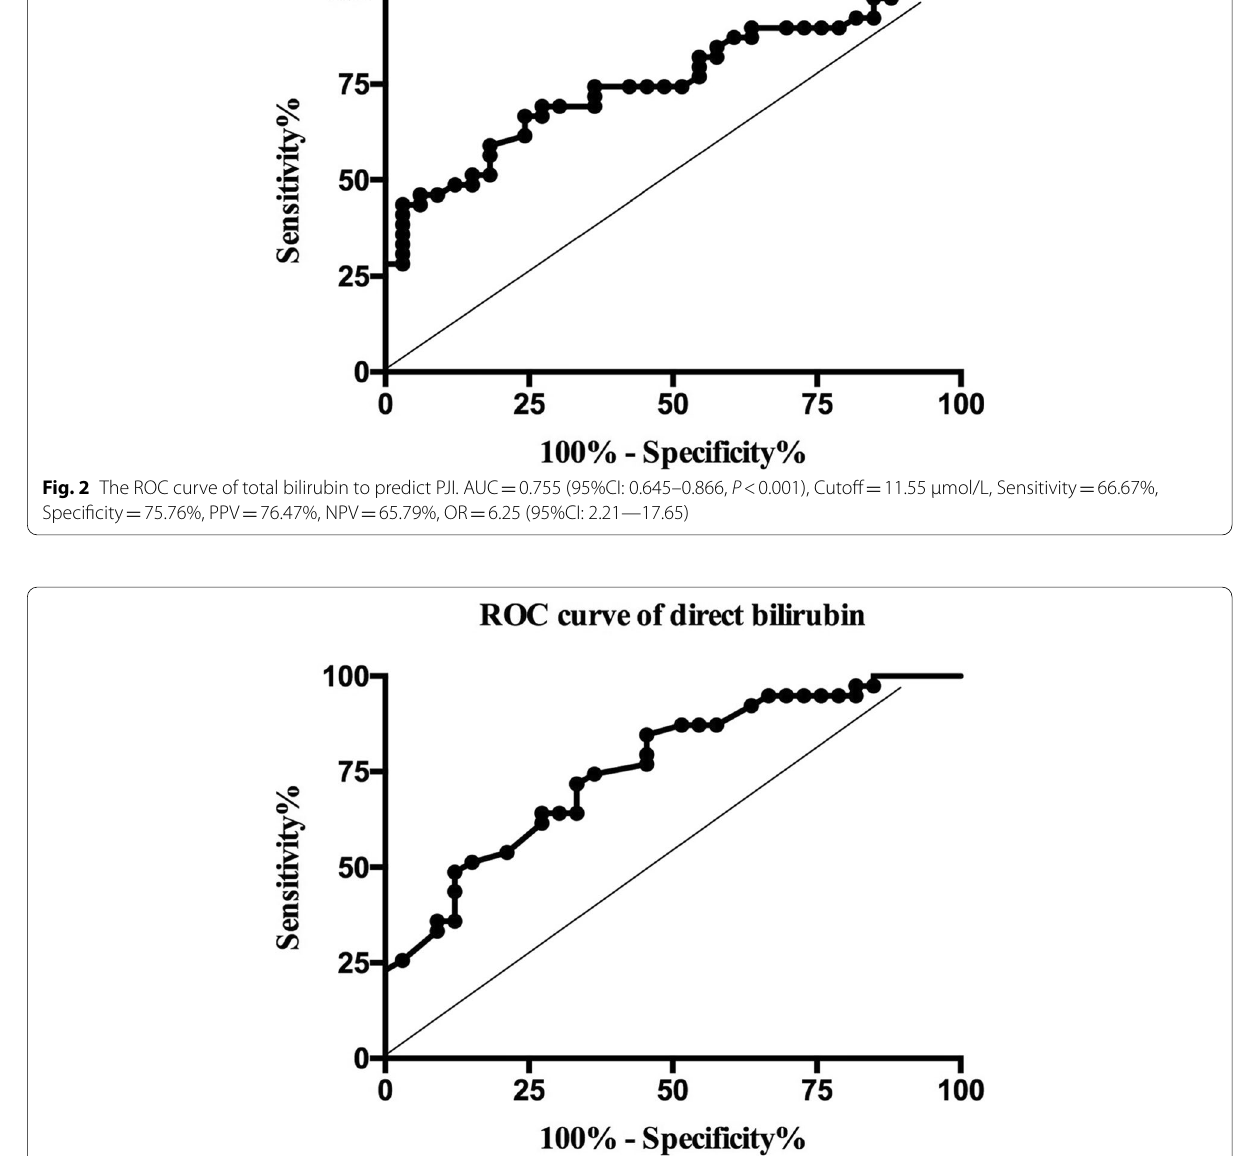
4.00 µmol/L, Sensitivity =